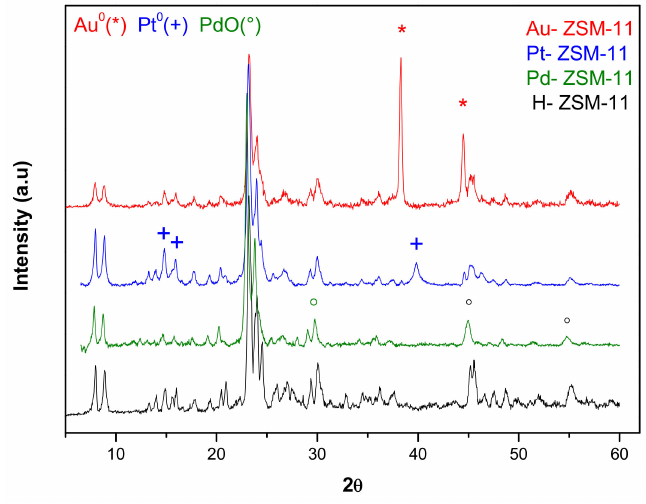
Figure 1. X-ray diffraction (XRD) patterns of monometallic catalysts Au-ZSM-11, Pt-ZSM-11, and Pd-ZSM-11, compared to the pristine H-ZSM-11 matrix.